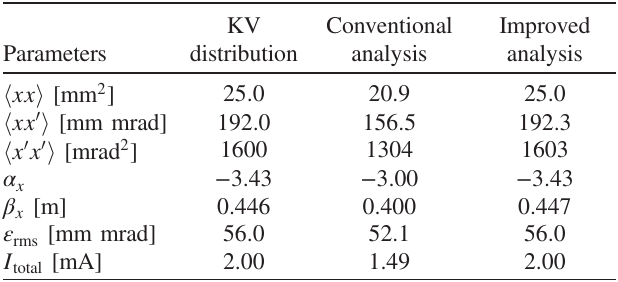
TABLE III. Beam parameters of the three distributions in Fig. 7.